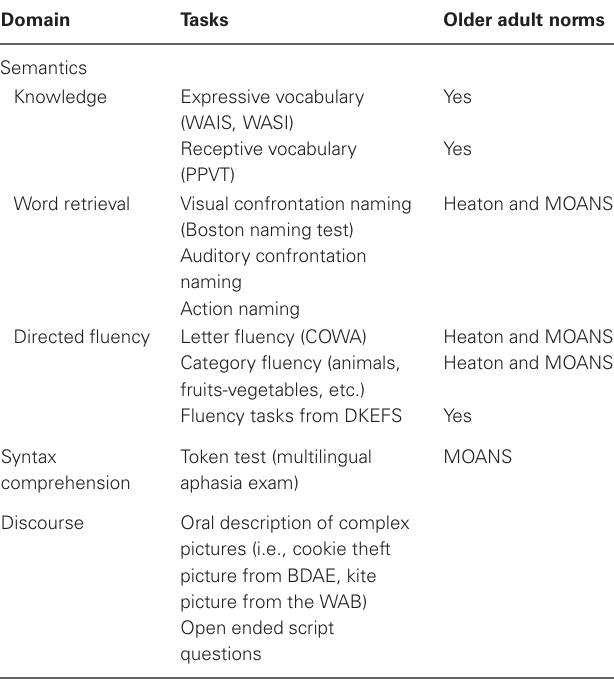
Table 3 | Commonly used language tasks in clinical assessment of non-aphasic older